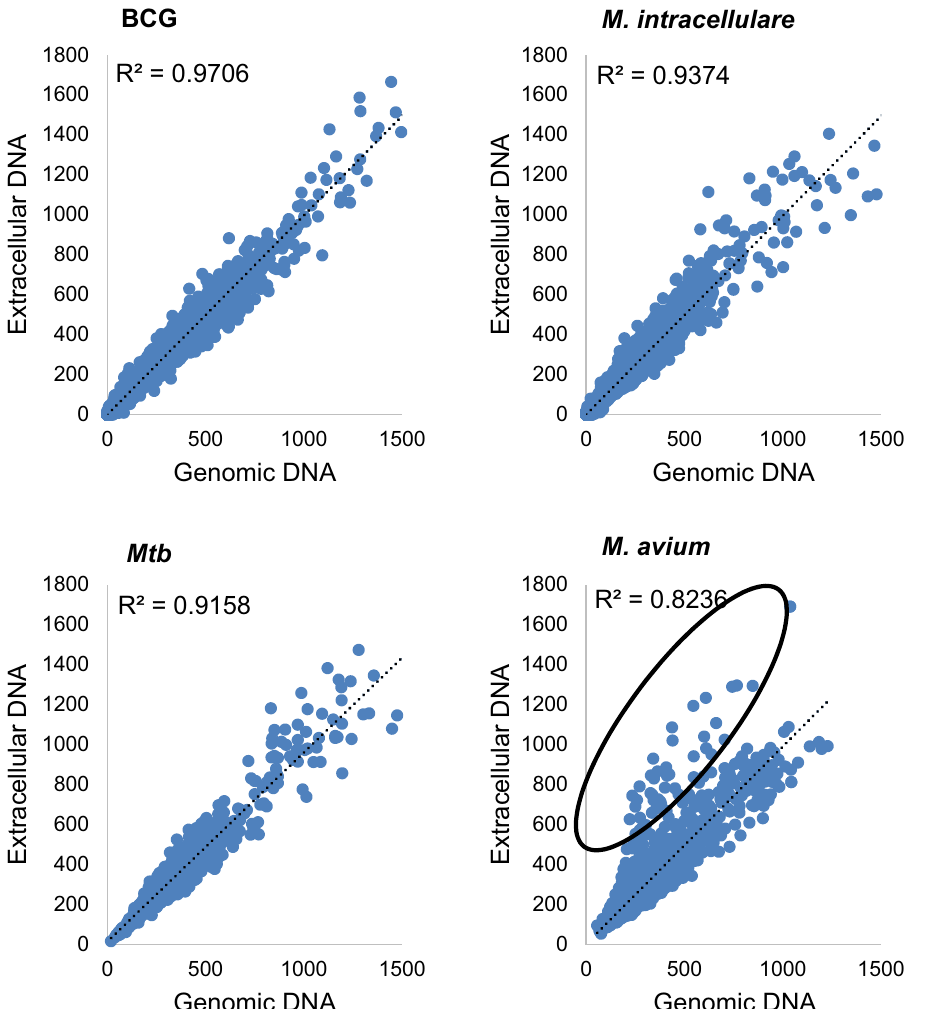
Figure 6. Whole genome sequencing comparison of gDNA and eDNA of BCG, M. intracellulare, Mtb, and M. avium. The relative abundance of gDNA and eDNA genes of BCG, M. intracellulare , Mtb, and M. avium were calculated. Each gene was plotted where the relative abundance of gDNA and eDNA correspond. The correlation of relative abundance of genes in each Mycobacterium species was 0.97, 0.94, 0.92, 0.82 for BCG, M. intracellulare , Mtb, and M. avium , respectively. The circle indicates accumulated genes in